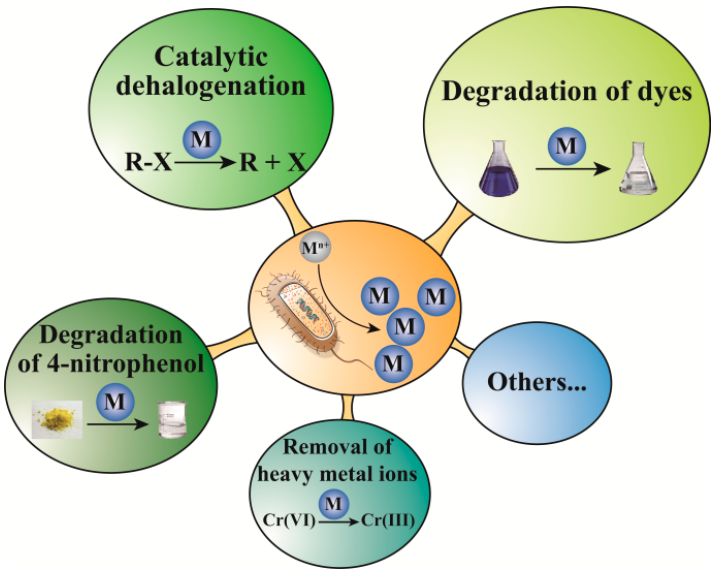
Figure 4. Catalytic applications of biosynthesized NPs, both elementary substances and compounds are included.